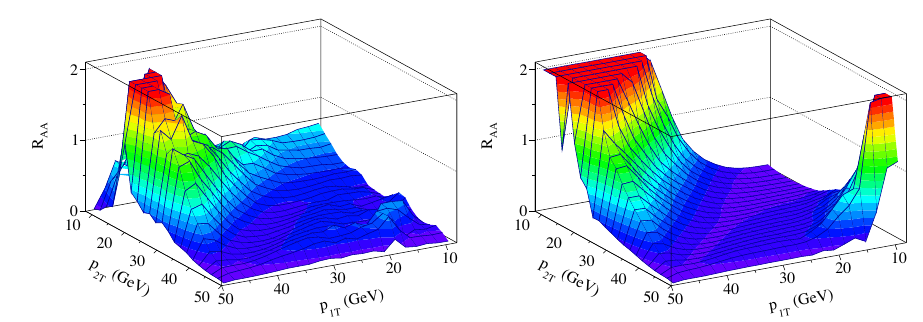
Figure 1. Nuclear modification factor for b-tagged (left) and inclusive (right) dijet production in Au + Au colli- sions at √ s NN = 200 GeV with sPHENIX kinematics